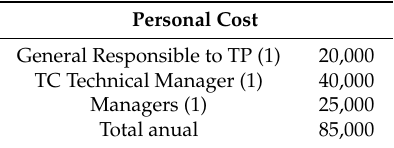
Table 5. Cost of workforce of the project